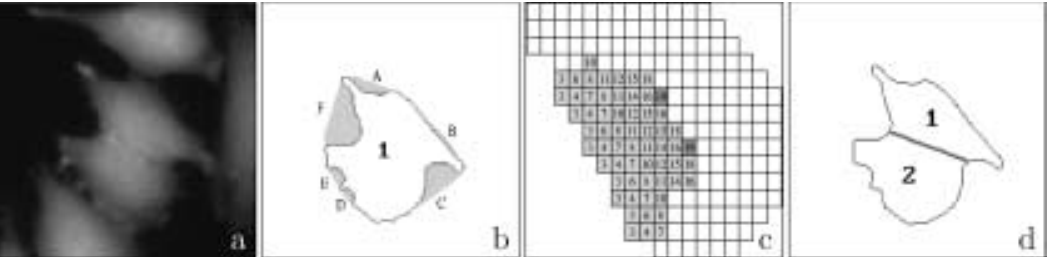
Fig. 7. The different steps in finding splitting lines. Original grey-scale image (a). The segmentation result where two cells have incorrectly been segmented as a single object. The convex deficiency of the object is shown as the shadowed areas around the borders of the object (b). This object contained 6 concavities labeled A to F. A close up of the concavity E is shown in (c). The numbers represent chamfer (3,4) distances to the border. Concavities C and F contain the final endpoints used for splitting the object. The splitting line has its endpoints where the concavities have their maximum distance value, i.e., the deepest point